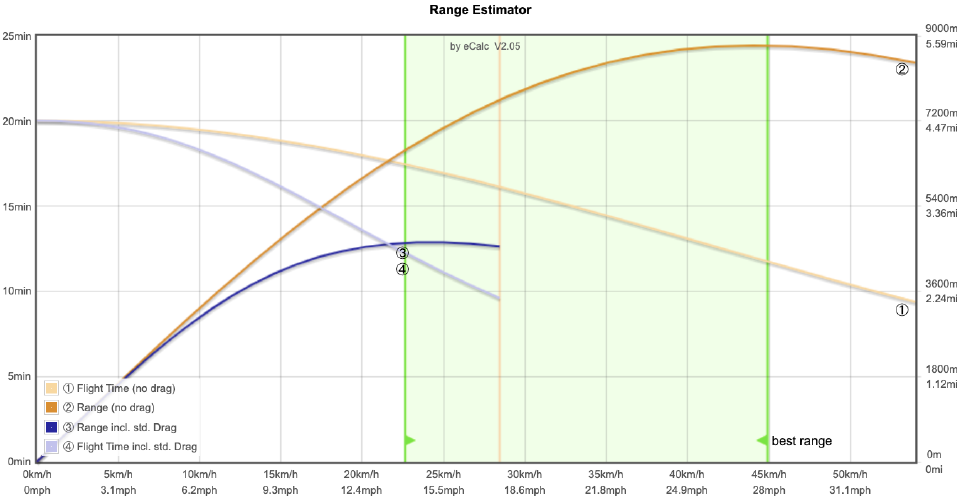
Figure 6. The eCalc [30] tool estimates the drone range and its general